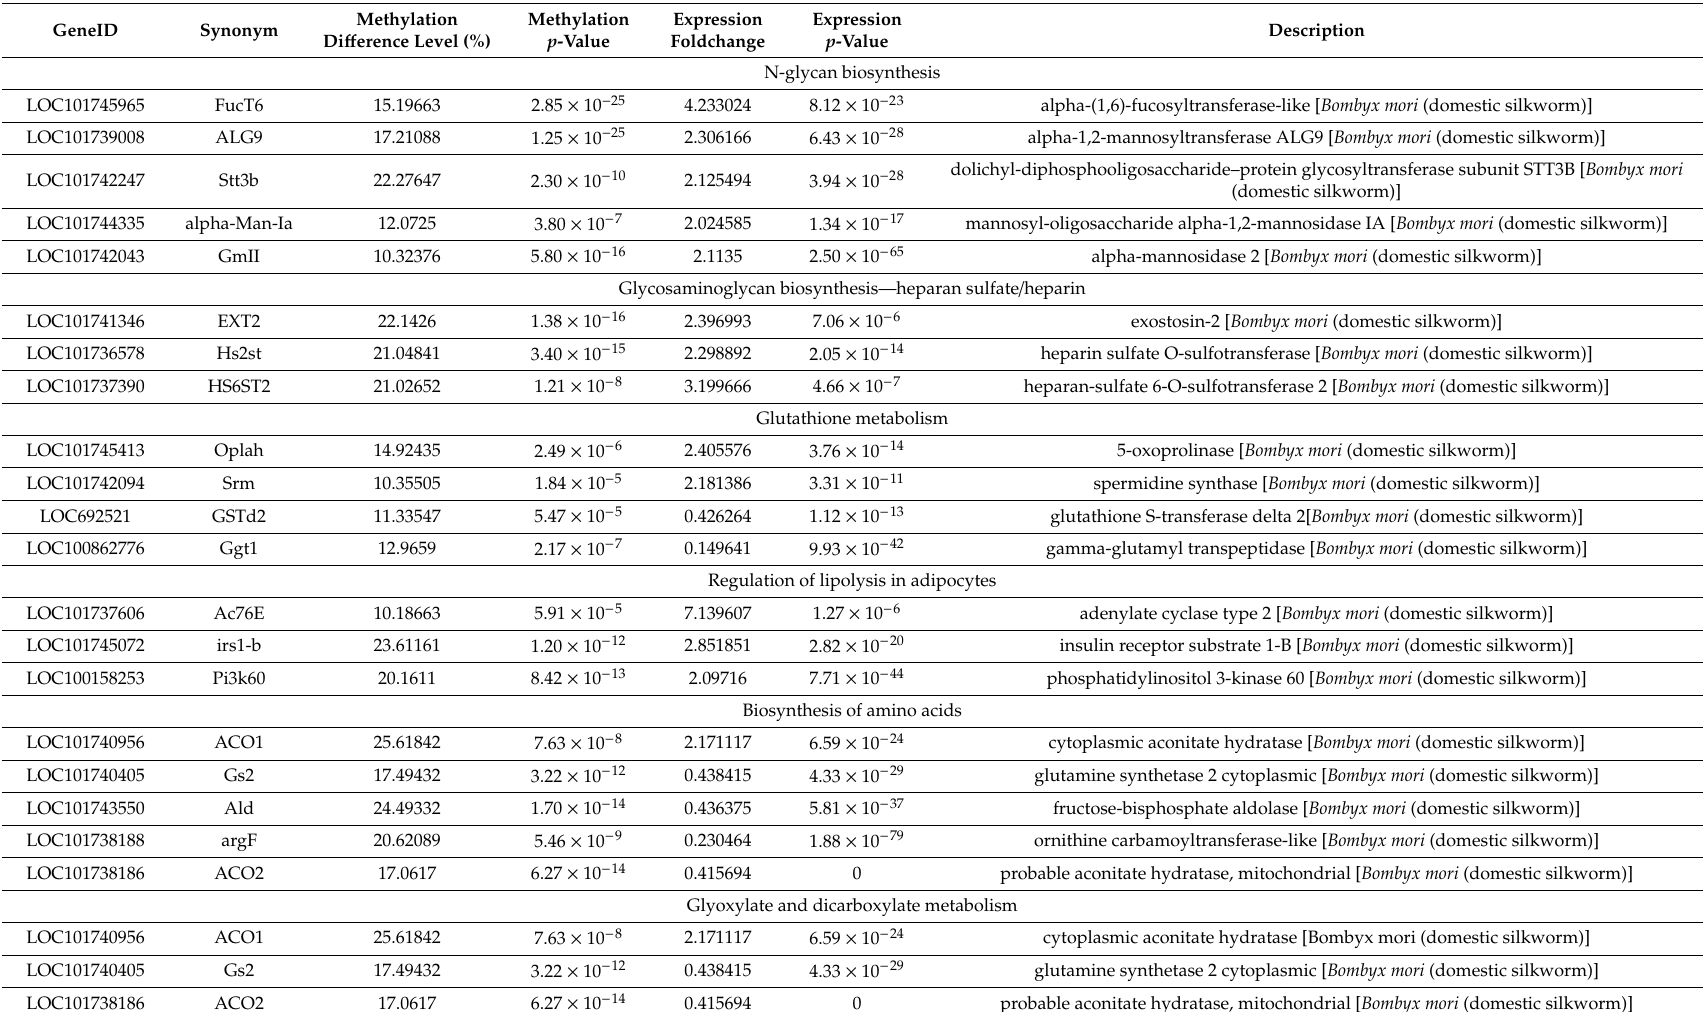
Table 3. Methylomes- and transcriptome-associated genes involved in metabolism